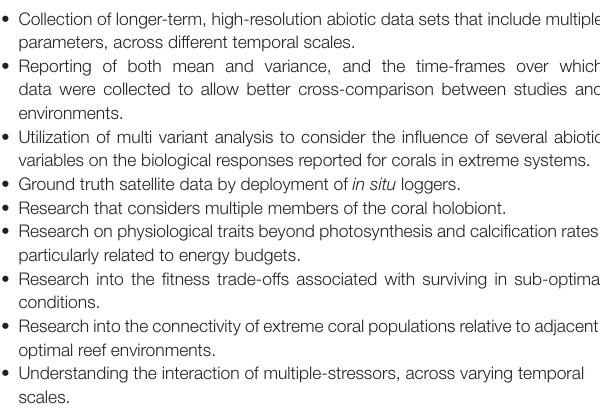
TABLE 1 | Future research